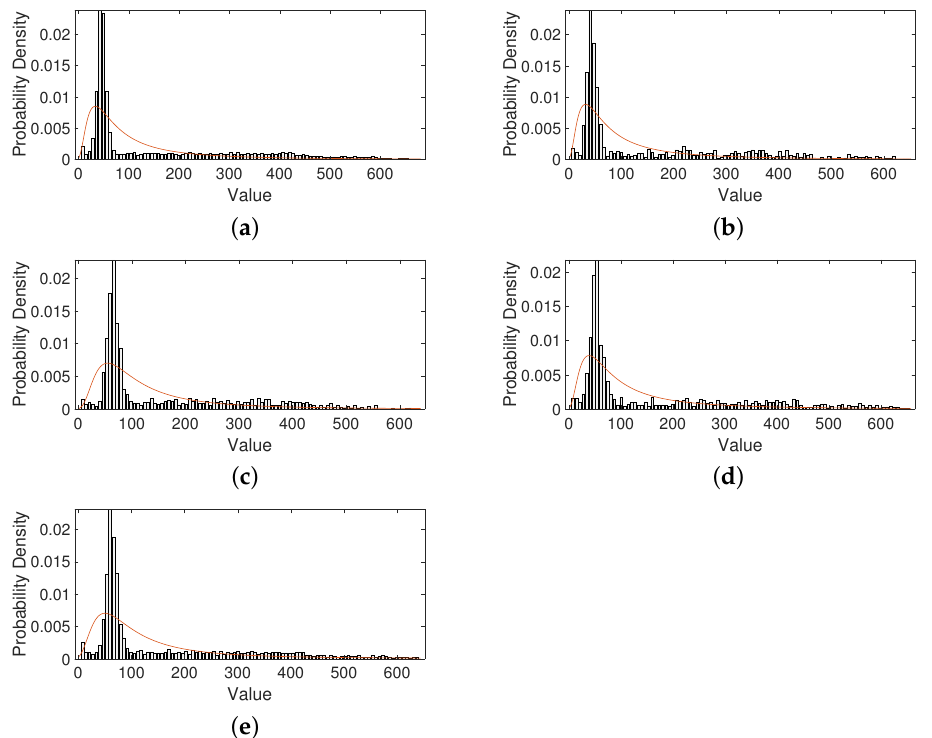
Figure 11. Histograms and generalized extreme value fitting from the raspberry diseases and defects used in this database. ( a ) Raspberries with albinism disease. ( b ) Raspberries with the fungus rust disease. ( c ) Raspberries with the over-ripeness defect. ( d ) Raspberries with peduncle defect. ( e ) Healthy